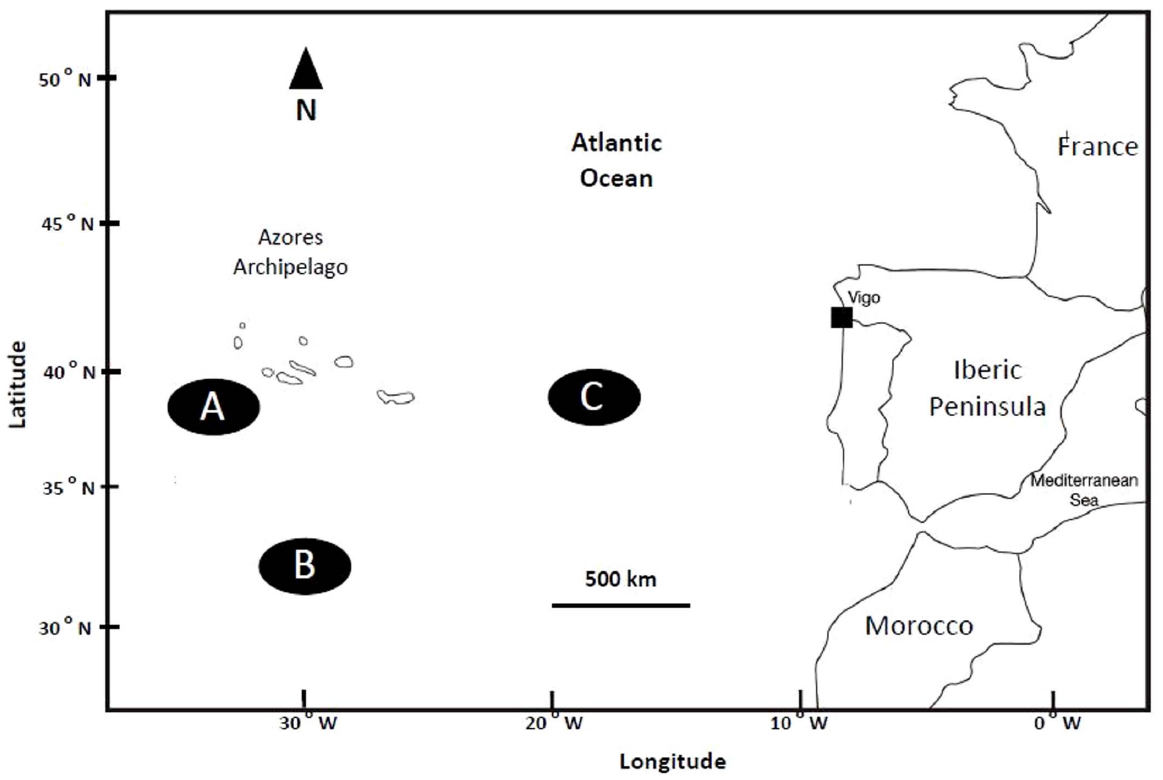
Figure 1. Distribution of the sampling areas (northeastern Atlantic). Zone A (southwestern of the Azores Archipelago), zone B (south of the Azores) and zone C (between the Azores and the Iberian Peninsula).